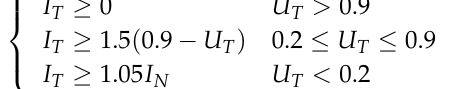
Table 1. Electrical parameters of Huawei SUN2000 PV inverter.